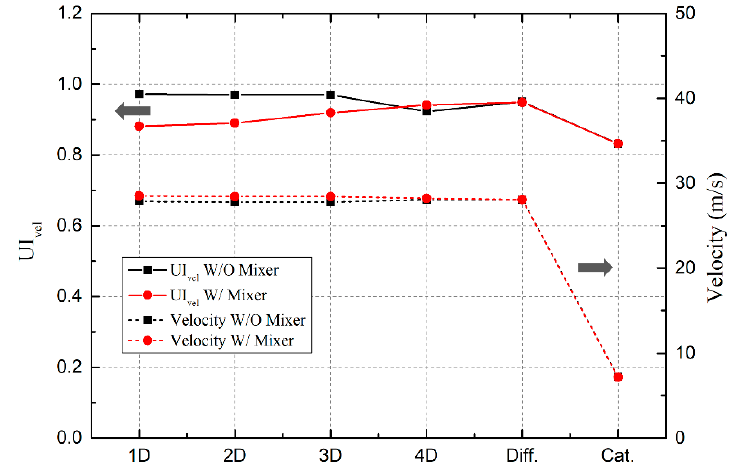
Figure 10. UI of axial velocity and mean axial velocity at specific locations with and without mixer.